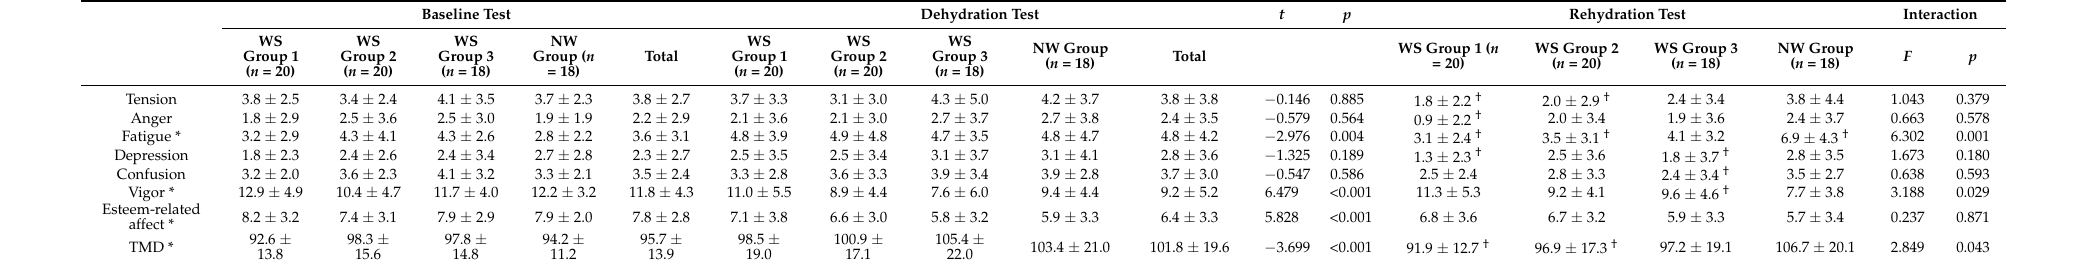
Table 6. The POMS of the